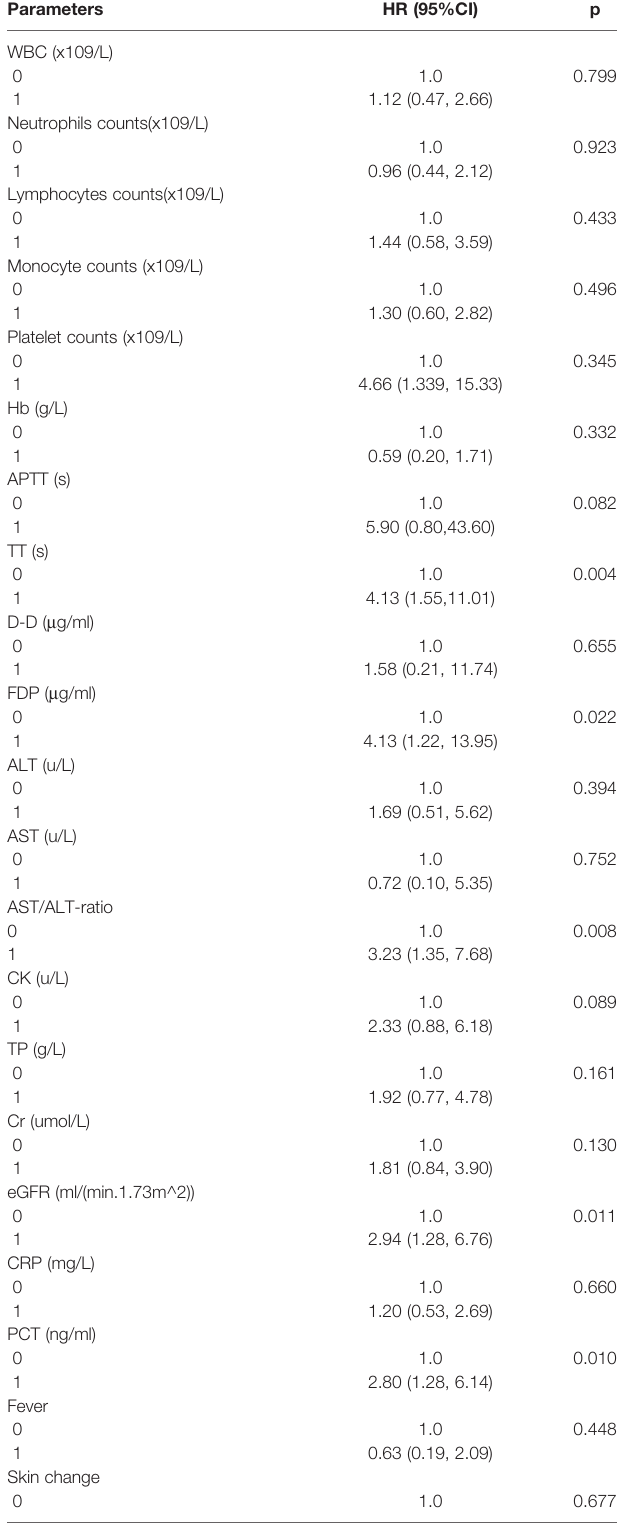
Model1: unadjusted. Model2: adjusted age and gender. Model3: adjusted age, gender, history of smoking, drinking, surgery, cardiovascular diseases, and